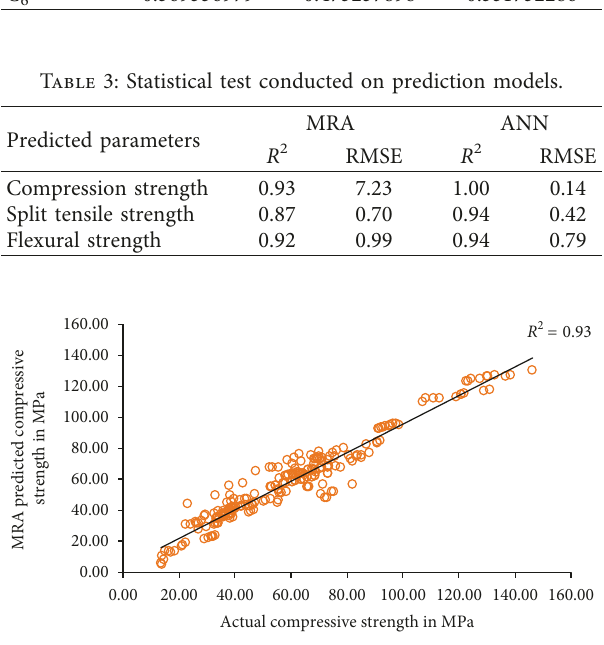
Figure 1: Actual vs. MRA predicted value for compressive strength.